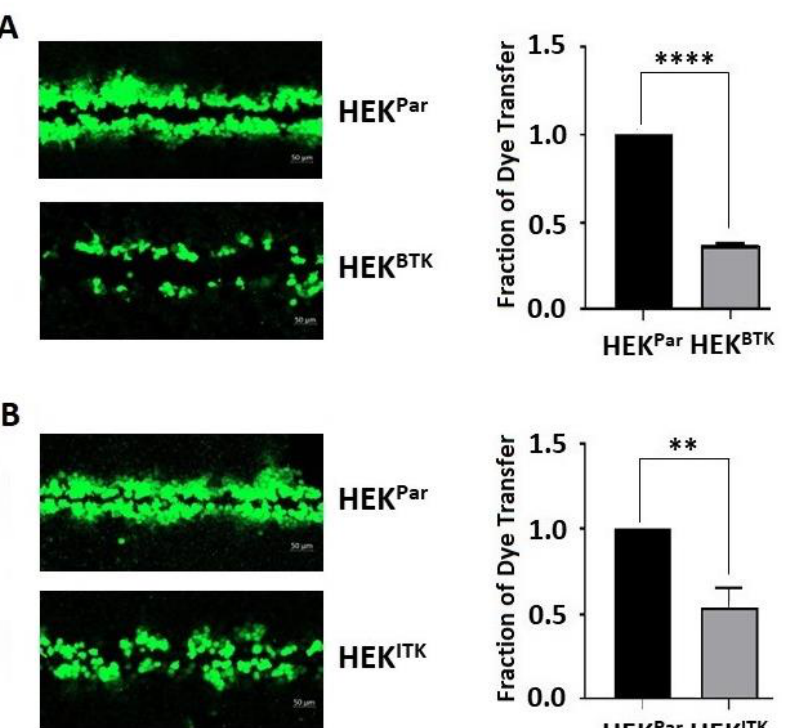
Figure 6. The effect of BTK and ITK phosphorylation on the Cx43 gap junction intercellular commu- nication in HEK-293T cells. A scrape loading dye transfer assay was used to assess communication from HEK-293T parental (HEK Par ) and ( A ) stably expressing BTK (HEK BTK ) or ( B ) stably expressing ITK (HEK ITK ) cells. Representative confocal images (Green, Lucifer yellow) are provided. Statistical data were calculated by ImageJ (all units measured in pixels) and GraphPad Prism by measuring the surface area of the transferred dye compared to HEK Par . Data represent the Student’s t -test ( n = 3, ** p < 0.01; **** p < 0.0001).